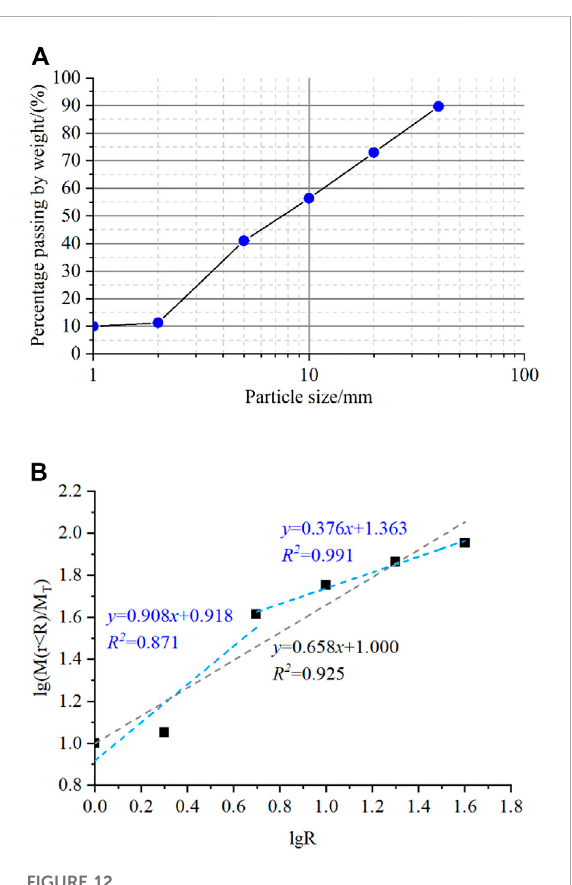
FIGURE 12 (A) Particle grain-size distribution and (B) fractal dimension curve of the S-RM